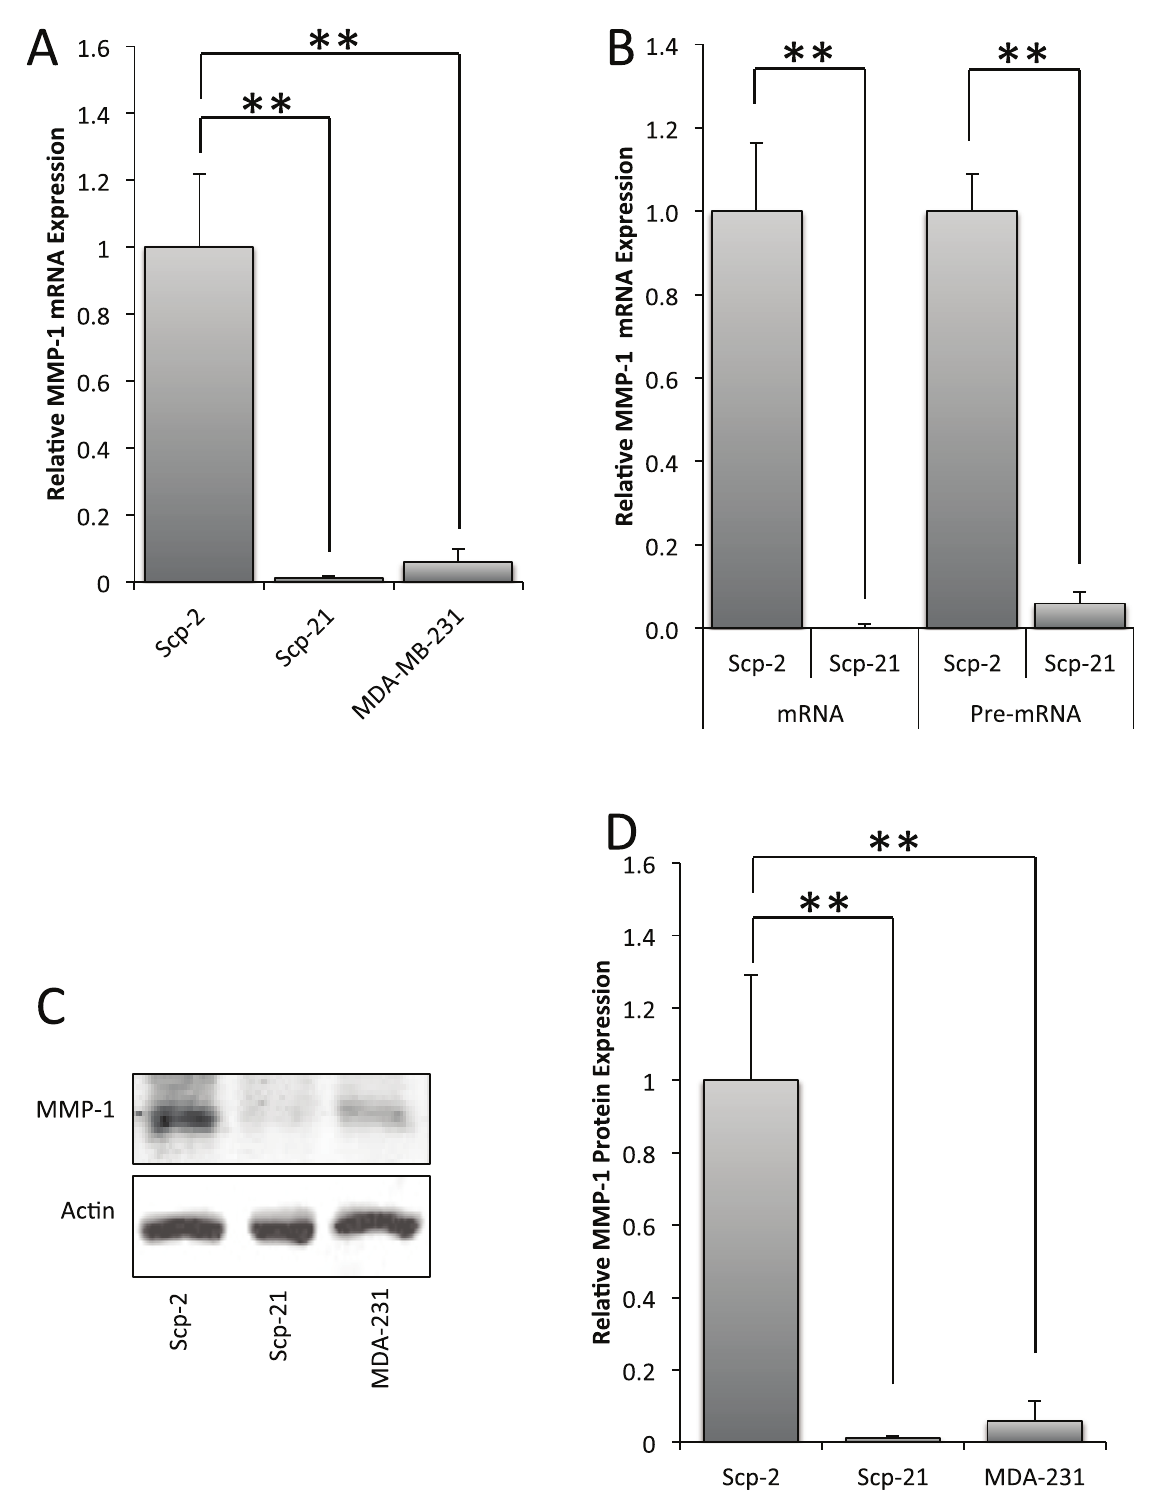
Figure 1. Differential expression of MMP-1 in MDA-MB-231 derivative cell lines. A ) qPCR of MMP-1 mRNA expression in Scp-2 (high metastatic potential), Scp-21 (non-metastatic) and MDA-MB-231 (low metastatic) cells. B ) qPCR of MMP-1 mRNA and pre-mRNA in Scp-2 and Scp-21 cells. Mean relative values +/- standard deviation from three independent experiments are shown. C ) Immunoblot with anti-MMP-1 antibody of whole cell lysates from Scp-2, Scp-21, and MDA-MB-231 cells. Anti-actin antibody served as a loading control. D ) Mean MMP-1 protein band intensity from immunoblots +/- standard deviation from three independent experiments. **, p < 0.005 for two-tailed t-tests.